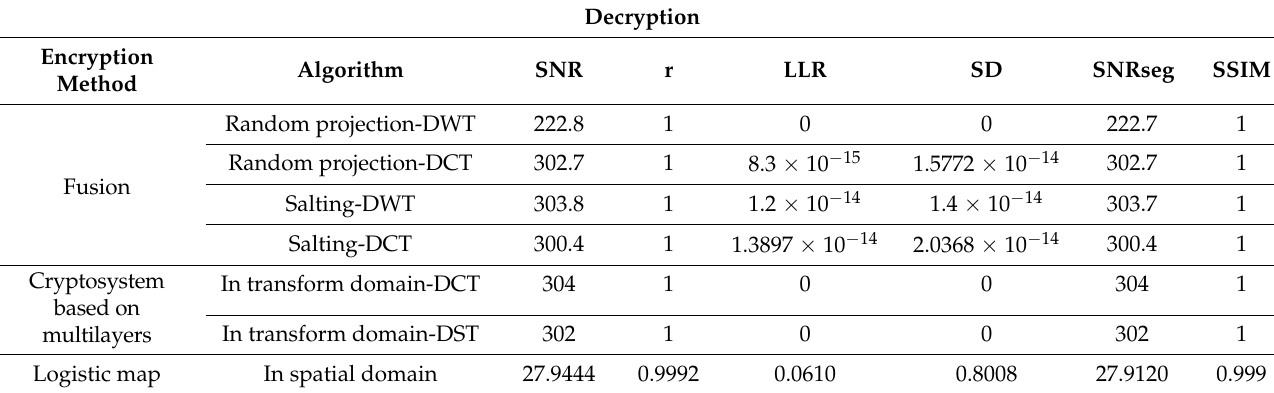
Table 3. Comparison of different decrypted